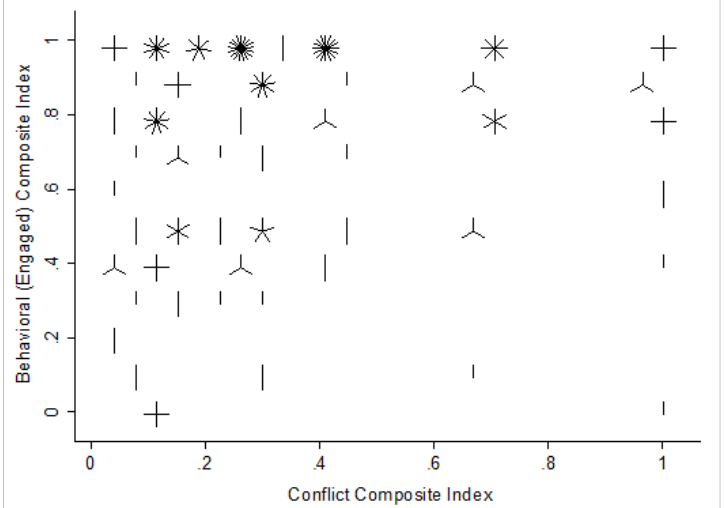
Figure 1. Density-Distribution Sunflower Plot for Conflict Composite and Behavioral Com- posite